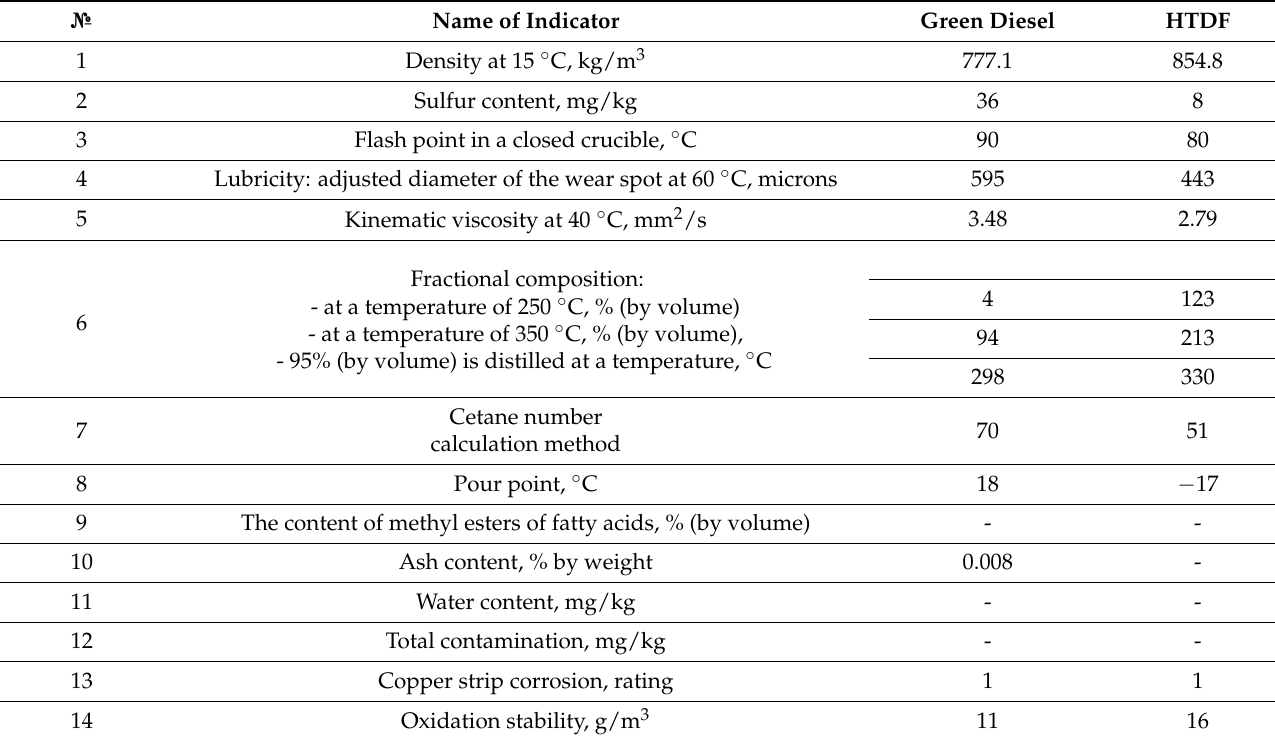
Table 1. Physicochemical characteristics of HTDF and the green diesel sample.